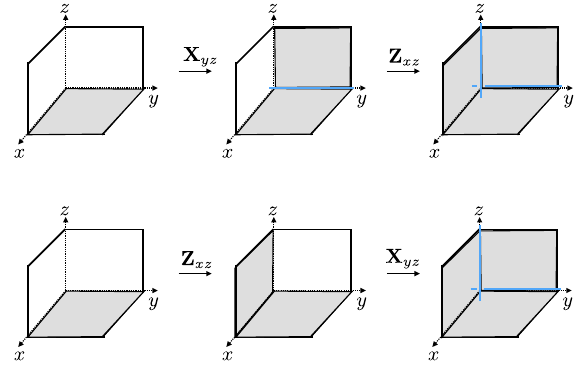
FIG. 15. Graphical illustration of the two orderings, Eqs. (44) and (45). They result in two states that differ by (cid:4) 1 in the nonanomalous model, but (cid:4) i in the anomalous projective semion model Y theory, as explained in the